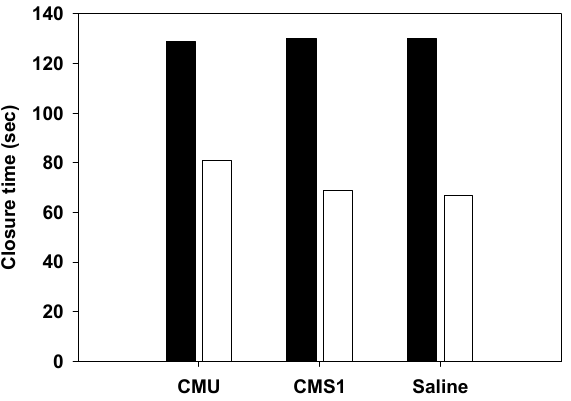
Figure 7. Platelet aggregation by W. cibaria strains. CMU, W. cibaria CMU; CMS1, W. cibaria CMS1. Saline was used as a negative control. C/EPI ( ■ ); C/ADP ( □ ).